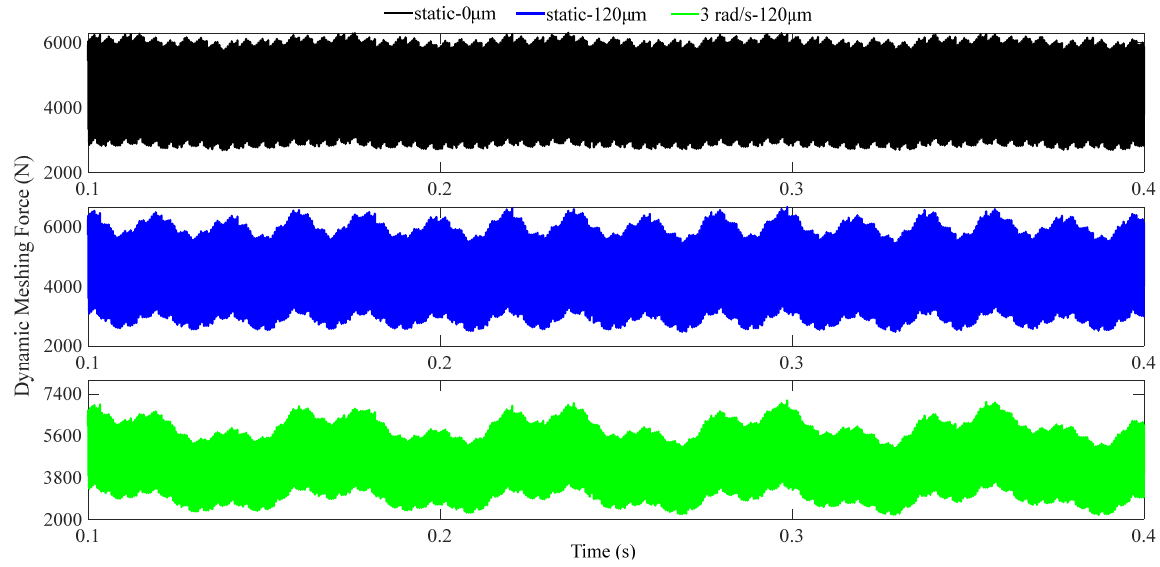
Figure 24. The time domain responses of the dynamic meshing force of sun-planet1 with manufac- turing errors.